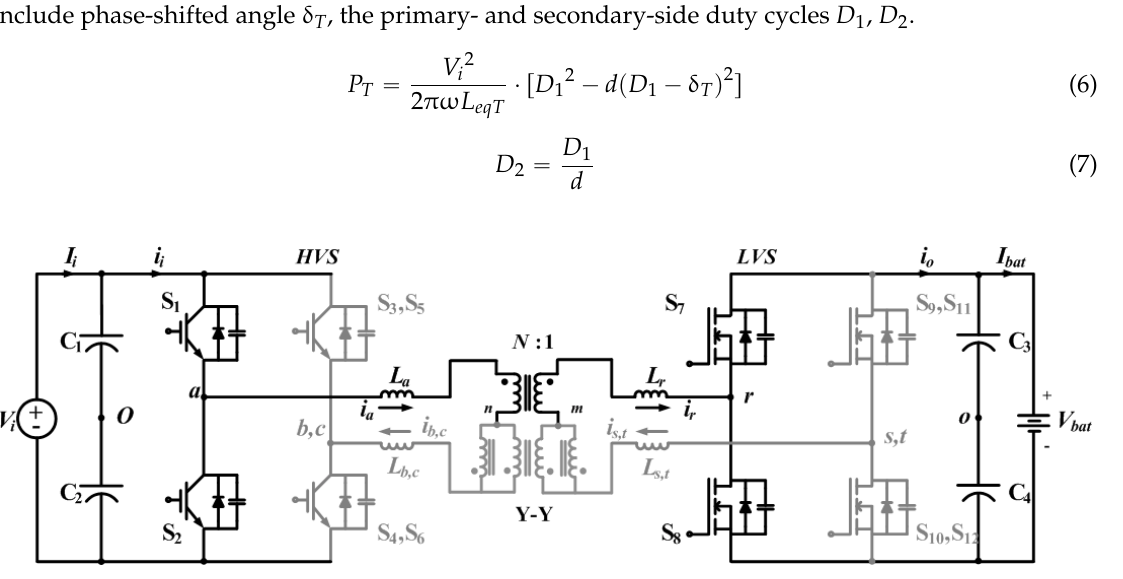
Figure 3. The equivalent circuit with trapezoidal modulation.